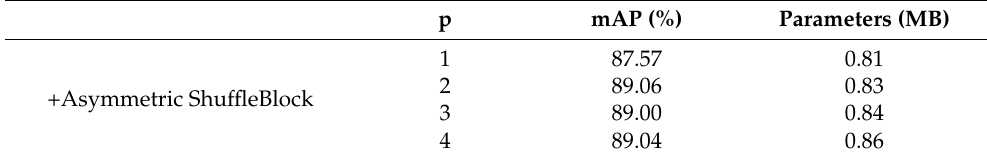
Table 5. Ablation study on expansion factor p.